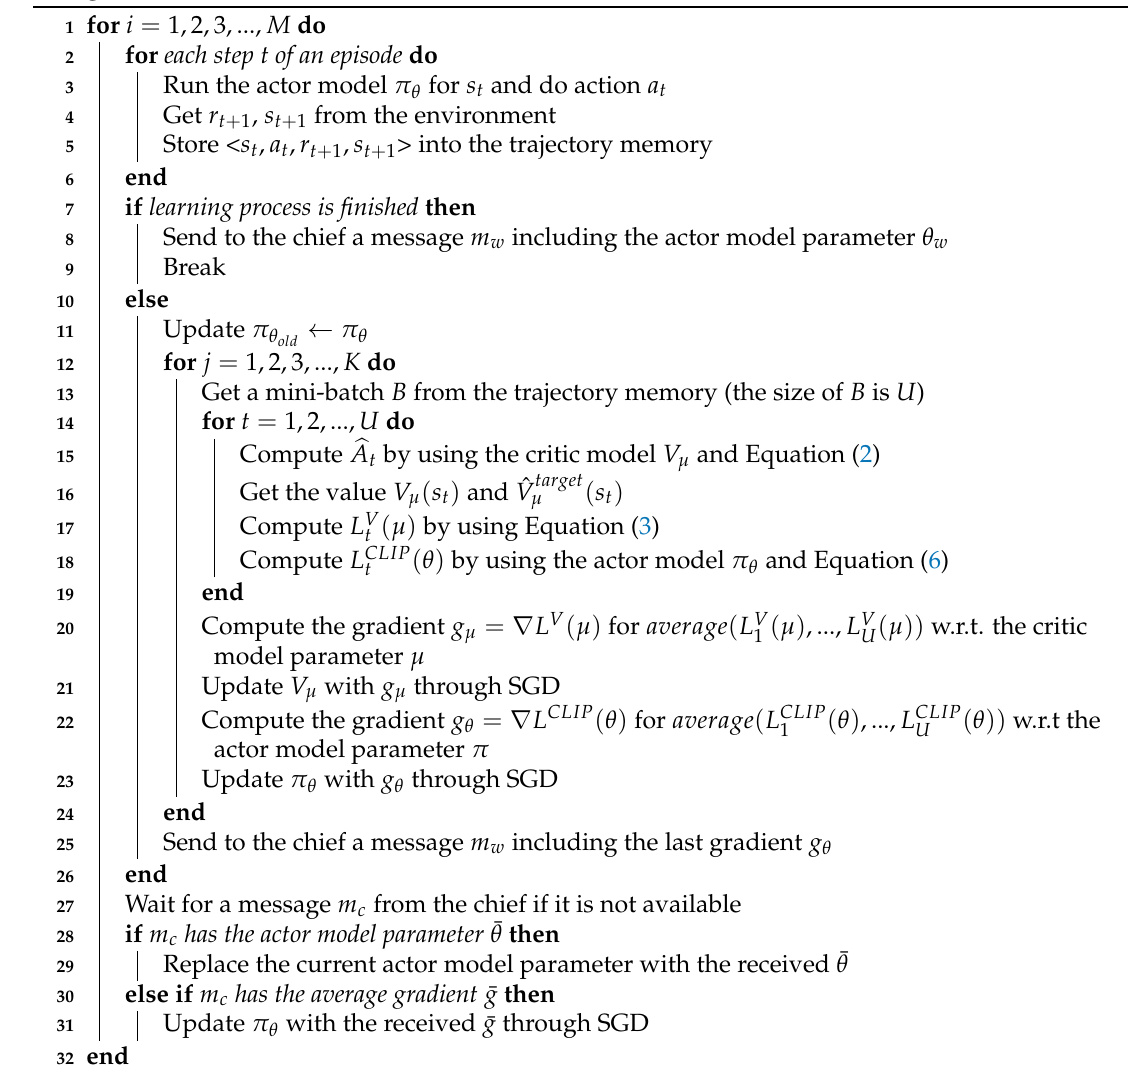
Algorithm 2: Federated RL (Worker w